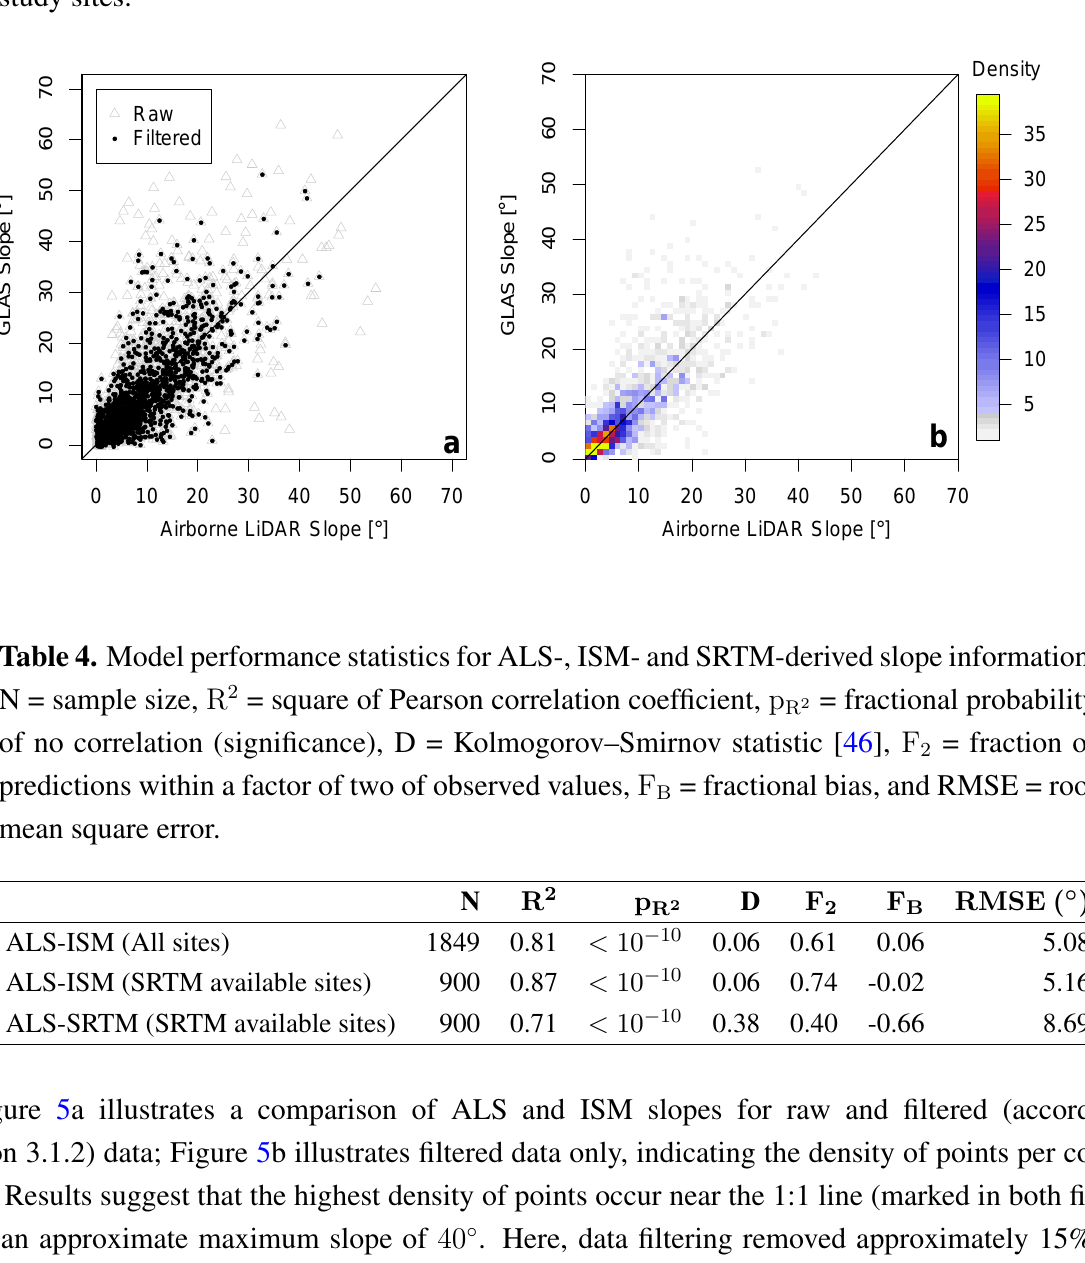
Figure 5. ( a ) Direct comparison and ( b ) density plot comparison of airborne LiDAR-derived (airborne LiDAR (ALS), filtered data only) slope and ISM-derived slope for all nine study sites.